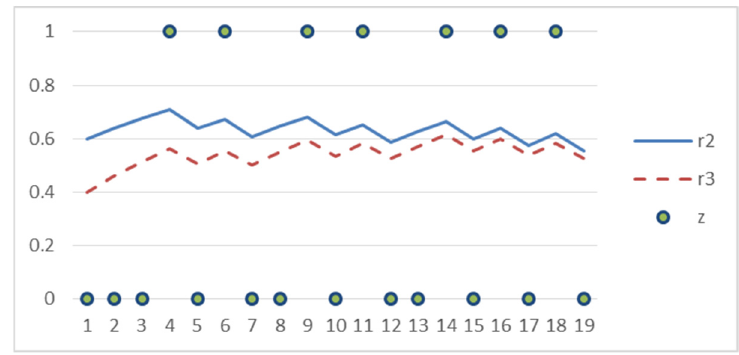
Figure 2. Dynamics of agents’ types and activity result in the example.